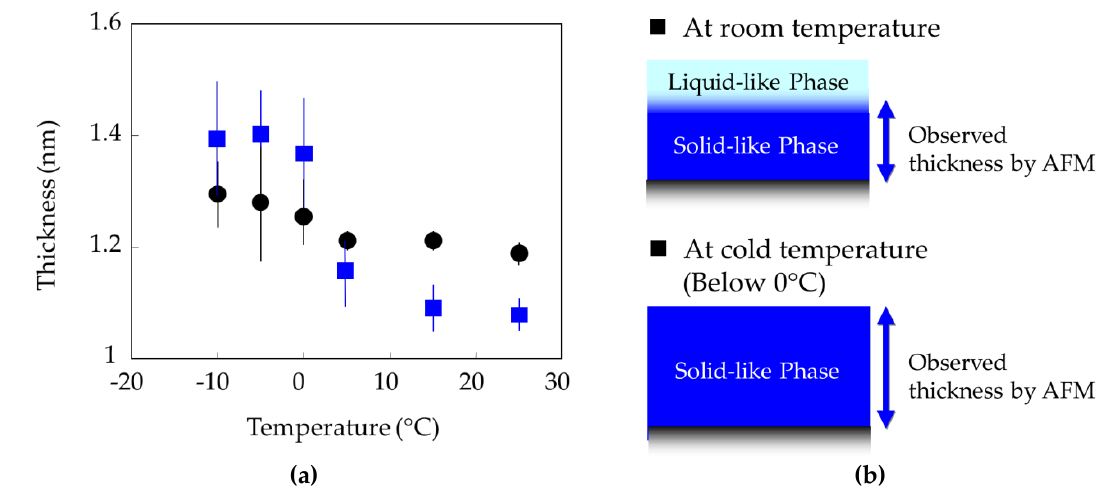
Figure 7. ( a ) Temperature dependency of AFM height image of adsorped layer on mica surface for 18-MEA / SPDA ( (cid:4) ) and n-HEA / SPDA ( (cid:8) ). The whiskers represent the standard deviations (n = 5). ( b ) Schematic image of observed thickness at room temperature and at cold temperature (below 0 ◦ C).